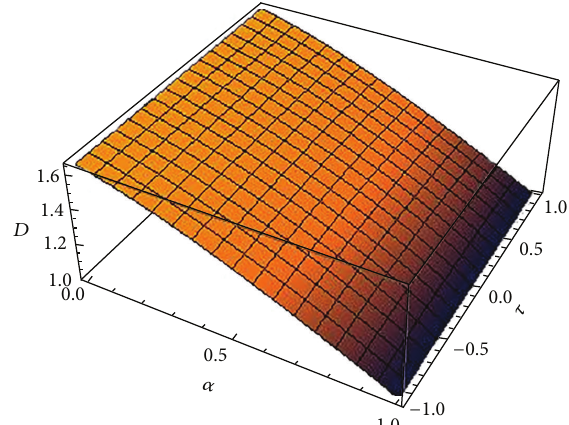
Figure 1: Quantum discord of (4) as a function of the impurity 𝛼 and |𝜏| = | Tr 𝑈 𝑛 | .